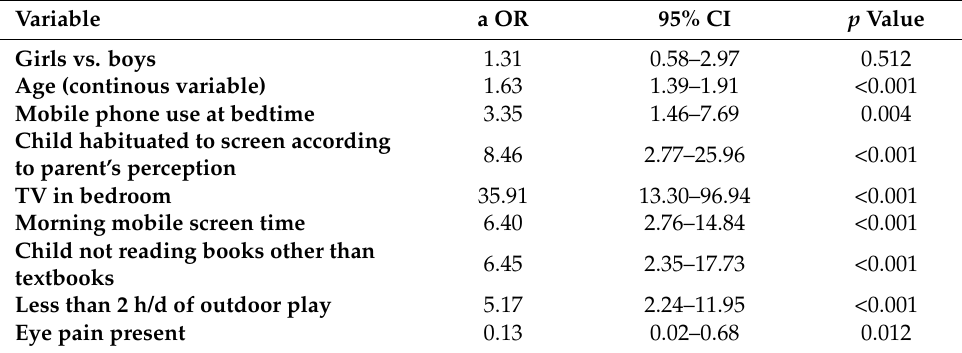
Table 3. Multivariate analysis of factors associated with >2 h/day of screen viewing time in 600 children included in the study with adjusted odds ratios (a